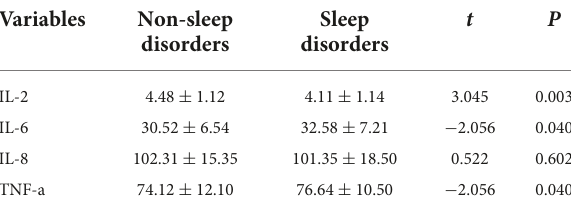
TABLE 5 Comparison of cytokine concentrations in oil workers with different sleep quality scores. among variables are shown in Table 8